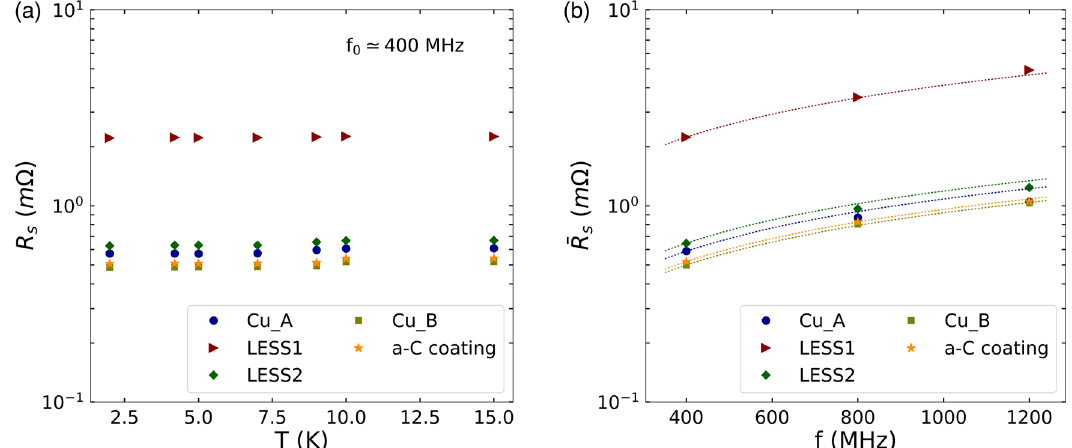
FIG. 5. (a) Surface resistance as a function of the sample temperature for pristine copper and for the different surface treatments. (b) Surface resistance averaged over the temperature as a function of the QPR mode frequency for pristine copper and for the different surface treatments. The curves show the functional dependence f 2 = 3 , having the data points at 400 MHz as a reference. Error bars are not shown for a better visualization of the different data points (measurement uncertainty δ R s =R s ≈ 10 %).